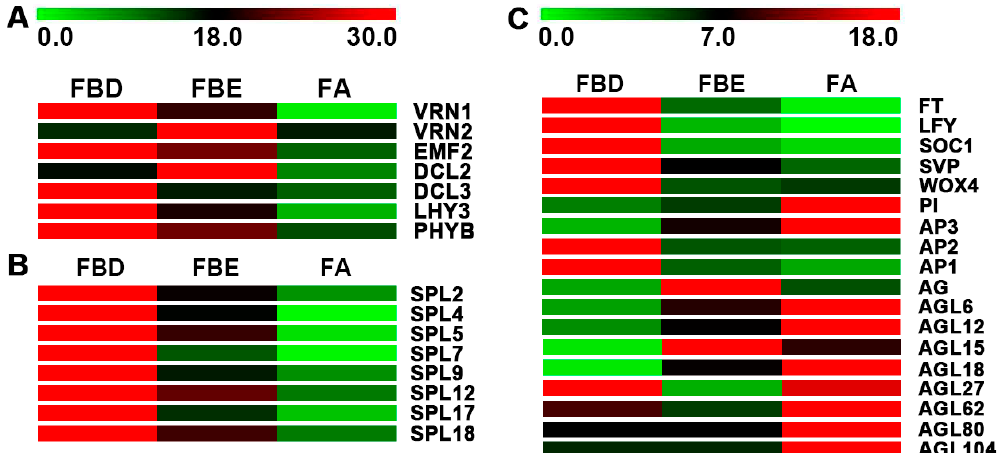
Figure 6. Expression changes of the genes involved in flowering-related pathways, floral integrator, floral meristem identity, and floral organ identity in flower development. ( A ) Expression levels of DEGs involved in flowering-related pathways. ( B ) Expression levels of DEGs encoding SPLs. ( C ) Expression levels of DEGs involved in floral integrator, floral meristem identity, and floral organ identity.